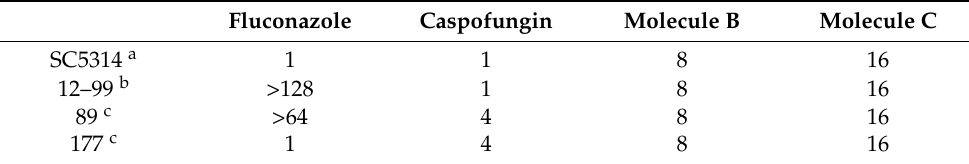
Table 2. MICs of Molecule B and Molecule C in C. albicans